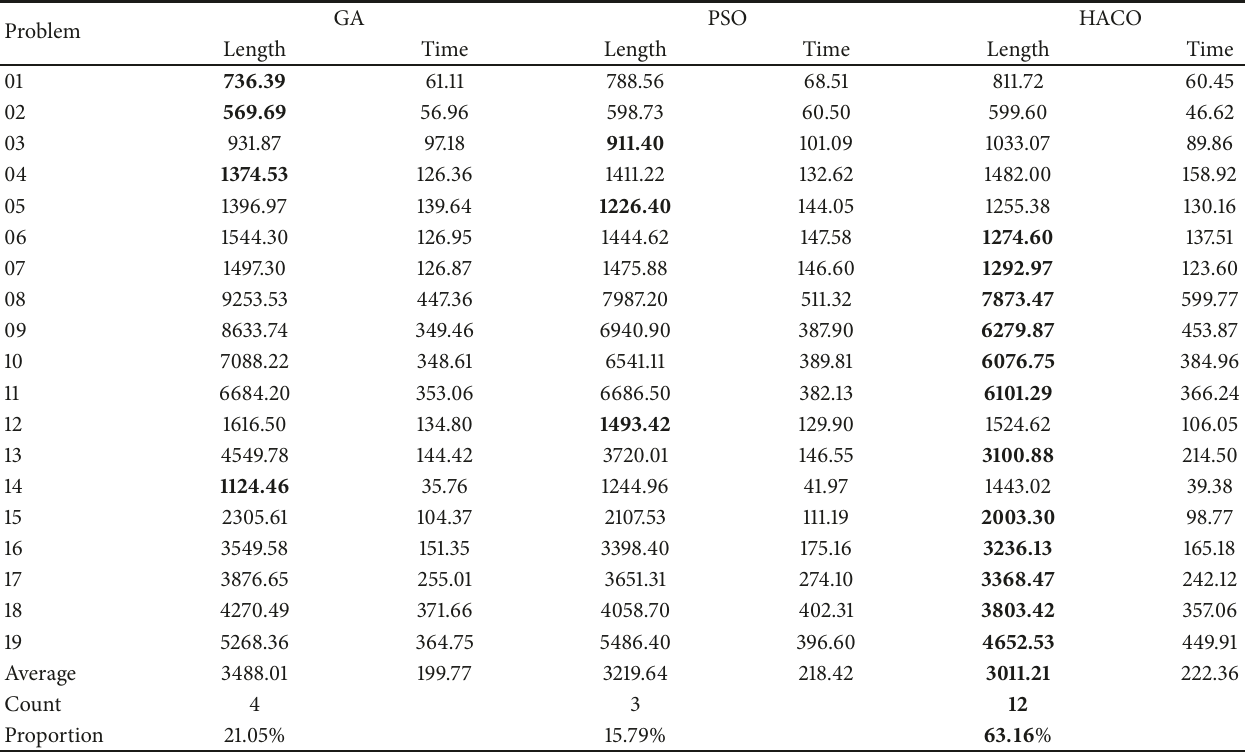
Table 7: Comparisons based on other two